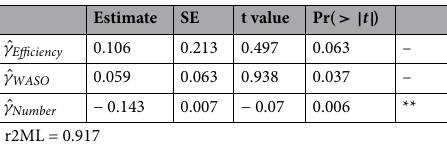
Table 4. Parameter coefficient estimation and significance levels.